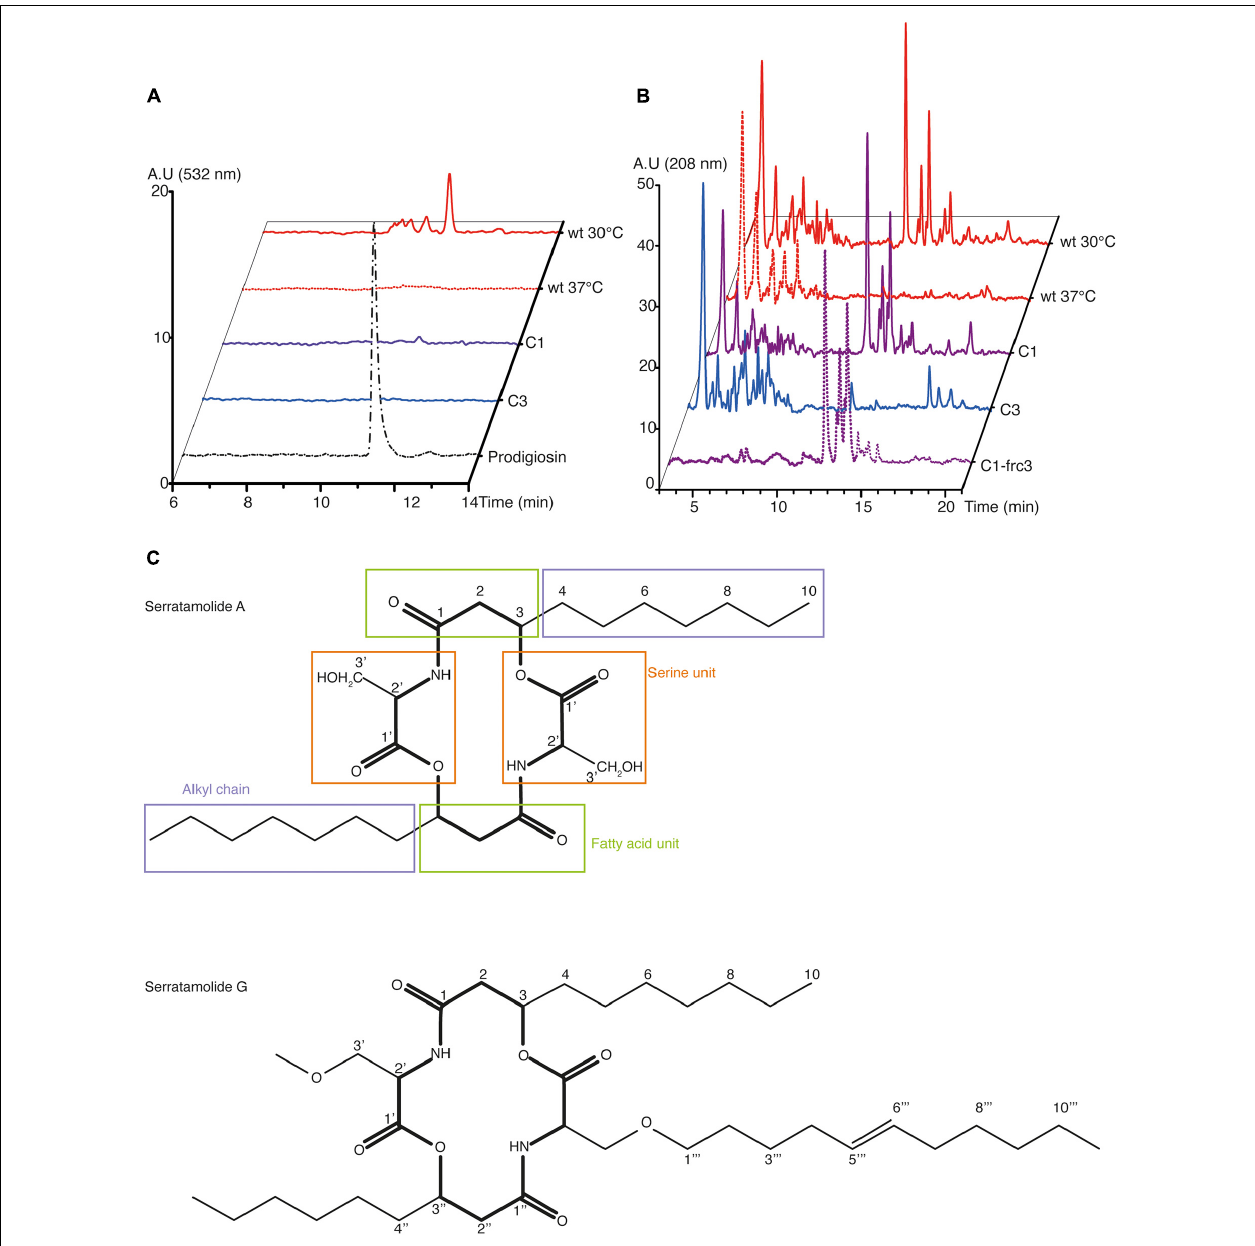
FIGURE 4 | HPLC and NMR analyses of the secondary metabolites produced by S. marcescens VA. (A,B) HPLC profile of S. marcescens VA extracts at the wavelengths reported to detect prodigiosin (532 nm, A ) and serratamolide (208 nm, B ). In (A) , the profile of purified prodigiosin was used as a control. In (B) , C1-frc3 shows data from the methanolic fraction, which has been analyzed via NMR. Data are representative of two independent experiments, and of one for C1-frc3. A. U, arbitrary units. (C) Structure of serratamolide A and G molecules, where the core indicated in bold. Serratamolide A encompasses a central symmetry and its different parts described in Table 1 are indicated in colored boxes: fatty acid unit in green, alkyl chain in purple, and serine unit in